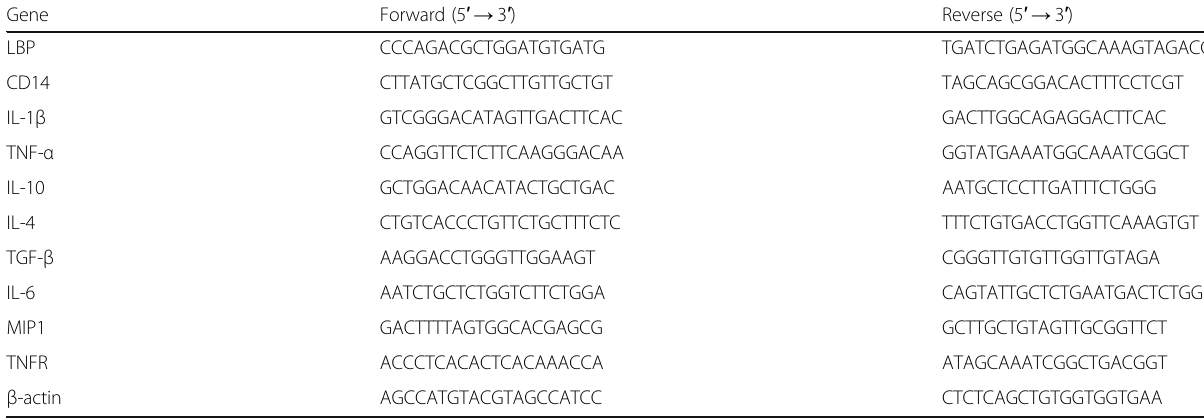
Table 1 Primers in